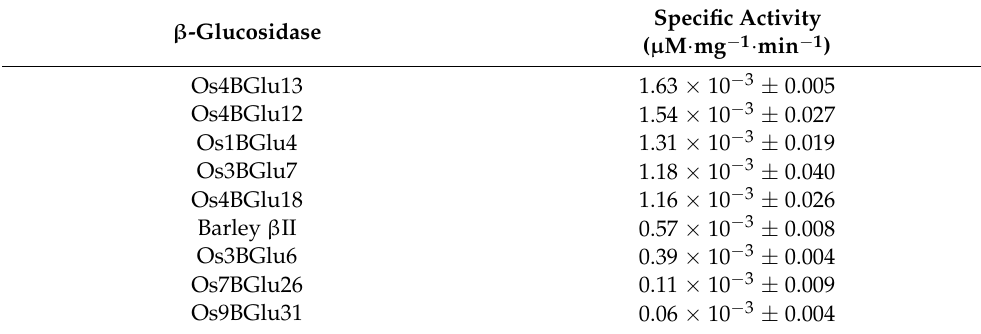
Table 1. ABA-GE hydrolysis activity of rice and barley GH1 β -glucosidases produced by recombinant expression in E. coli . The activities were assayed by incubating 0.25 µ g of enzyme with 1 mM ABA-GE in 50 mM buffer (sodium acetate, pH 5) at 30 ◦ C for 30 min.